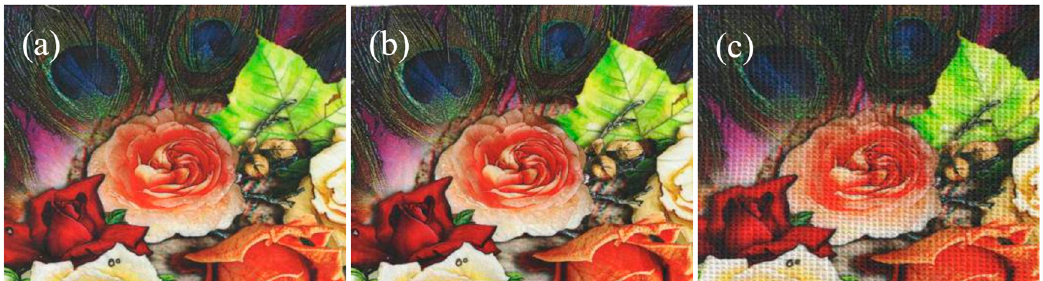
Figure 7. The mechanism of nanospheres modification and ink-jet printing of cotton fabrics.